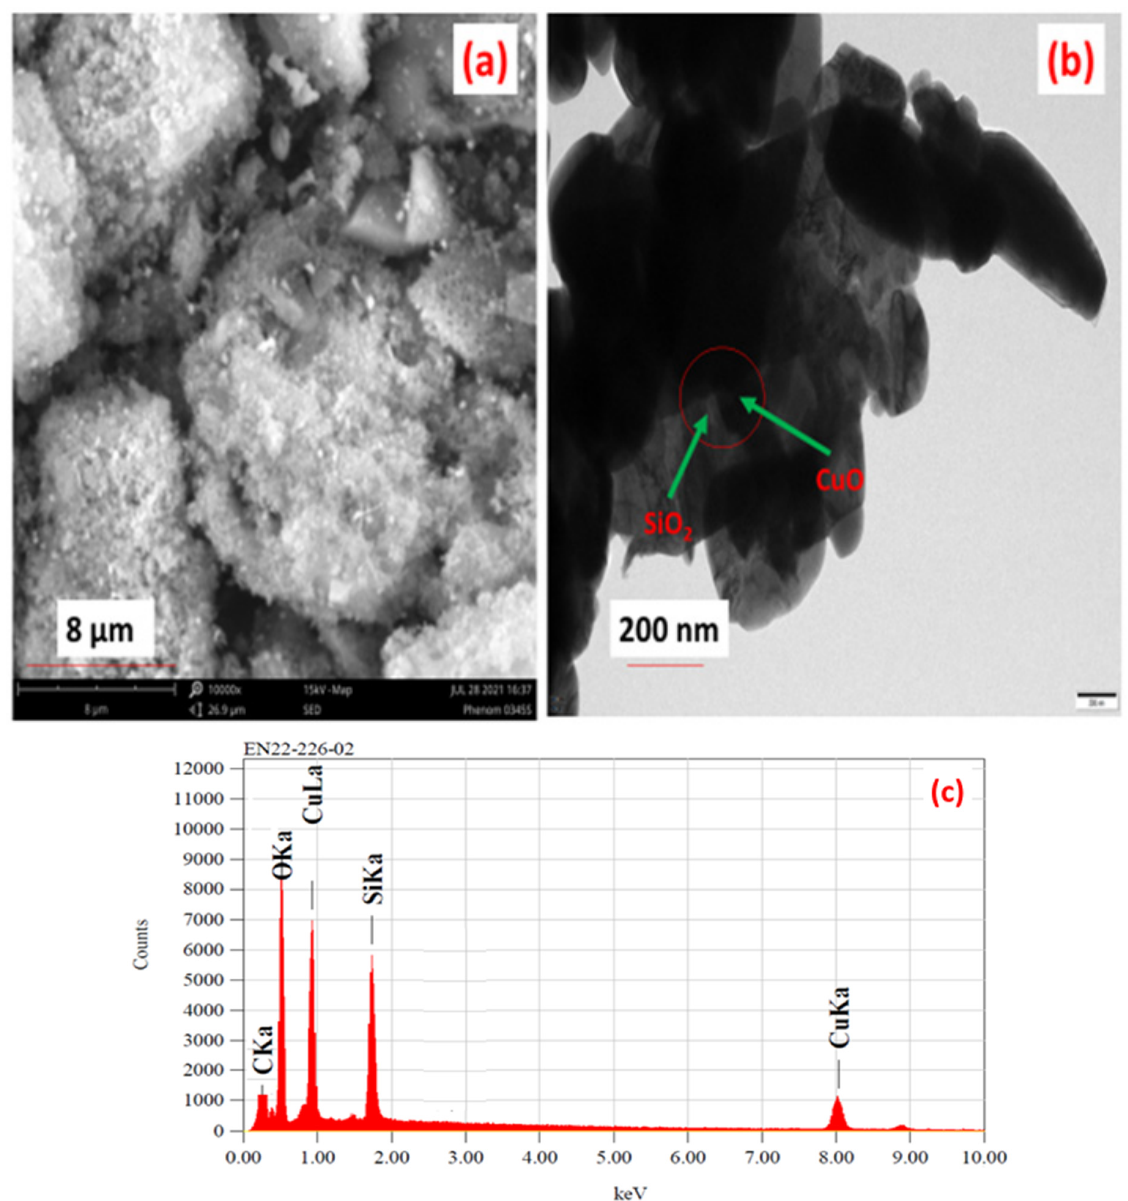
Figure 2. ( a ) SEM and ( b ) TEM images, and ( c ) EDX spectra of the CuO–SiO 2 composite.